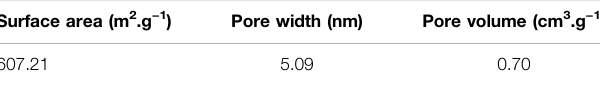
TABLE 4 | Surface area and pore size results of the recovered Pd@Py 2 PZ@MSN catalyst. Surface area (m 2 .g − 1 )